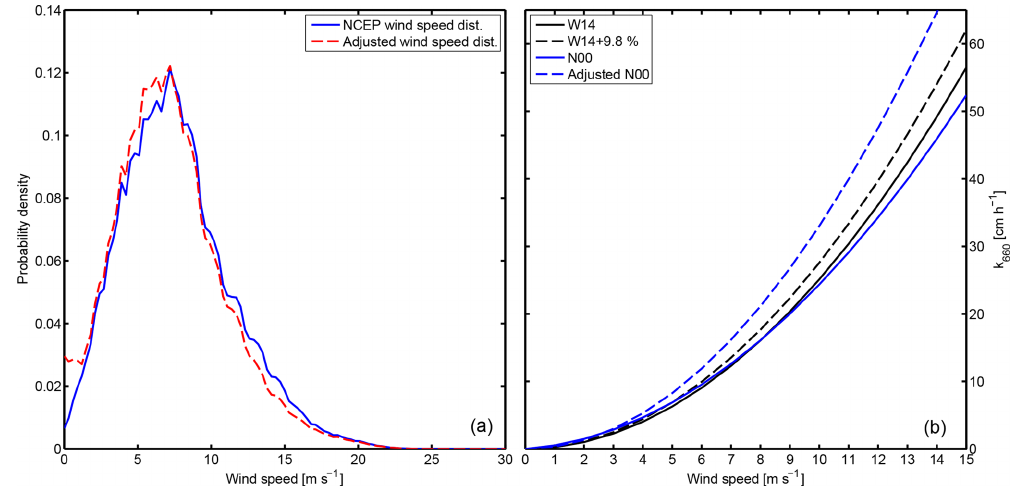
Figure 6. Wind speed distributions for the year 2014 (a) . The solid line is NCEP-derived wind speed distribution, the dashed line the wind speed distribution of the adjusted wind speed u alt . Comparison of original and adjusted k vs. wind speed parameterizations (b)